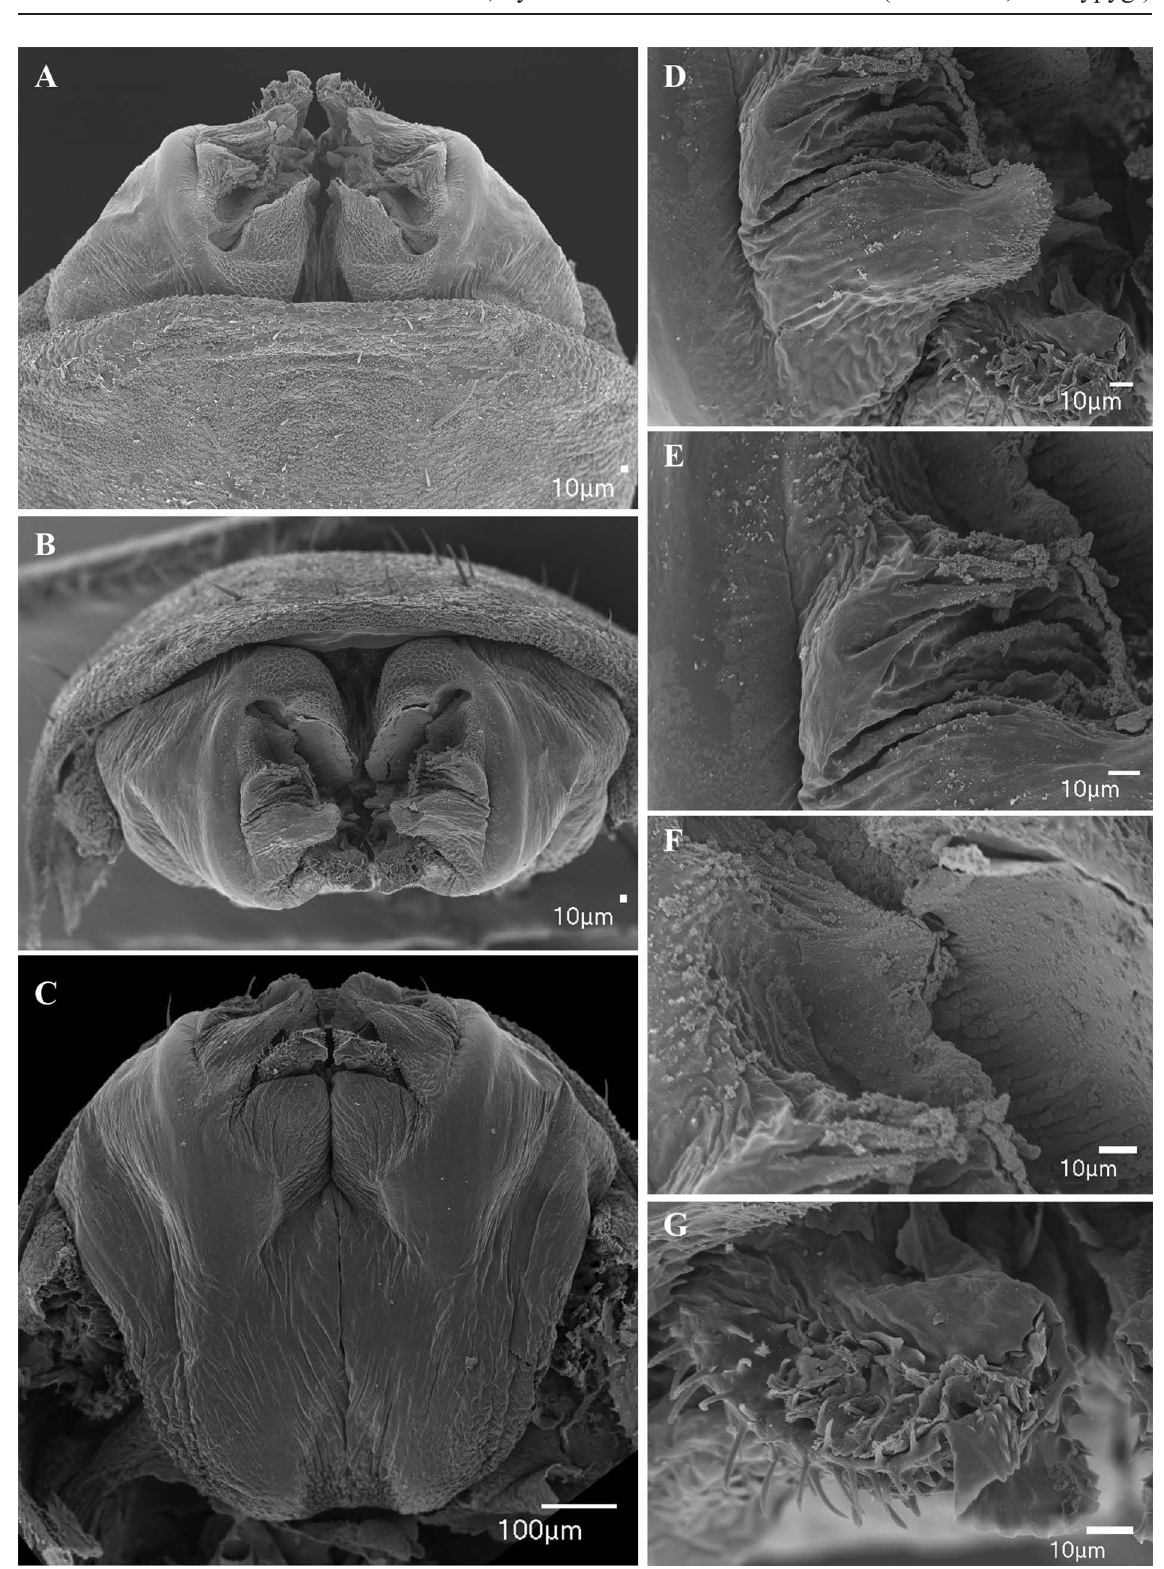
Fig. 15. Charinus aguayoi Moyá-Guzman, 2009 (USNM 392988), male gonopod. A . Ventral view. B . Posterior view. C . Dorsal view. D . Detail of lateral lobe 1. E . Detail of lateral lobe 2. F . Detail of processus internus. G . Detail of apex of